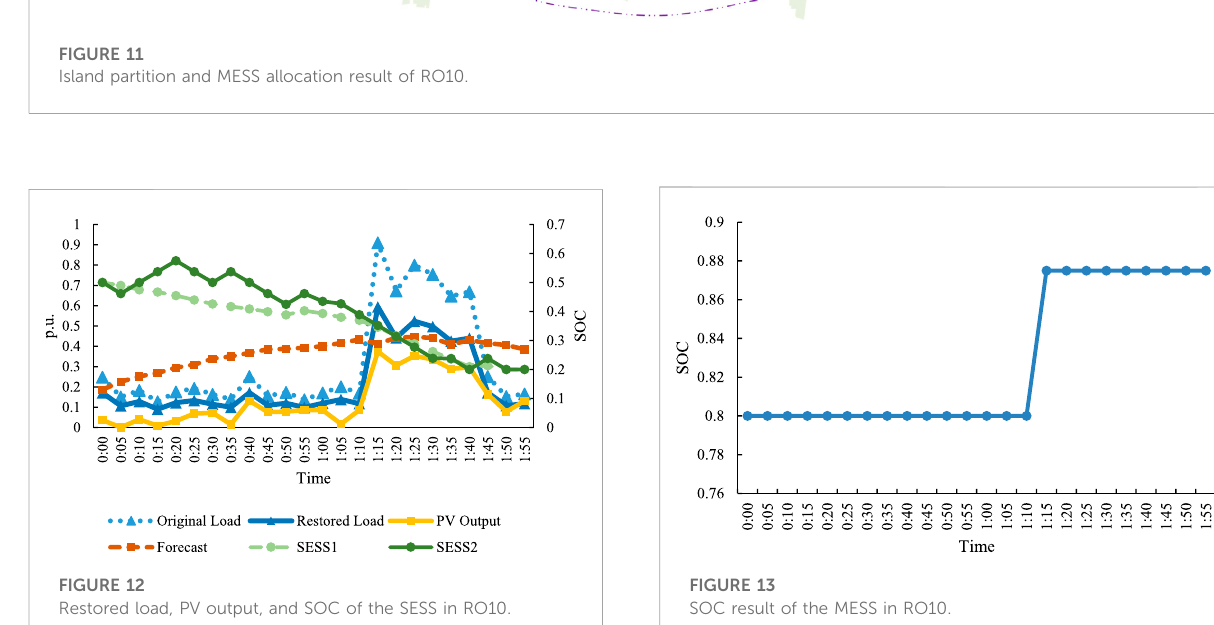
FIGURE 12 Restored load, PV output, and SOC of the SESS in RO10.